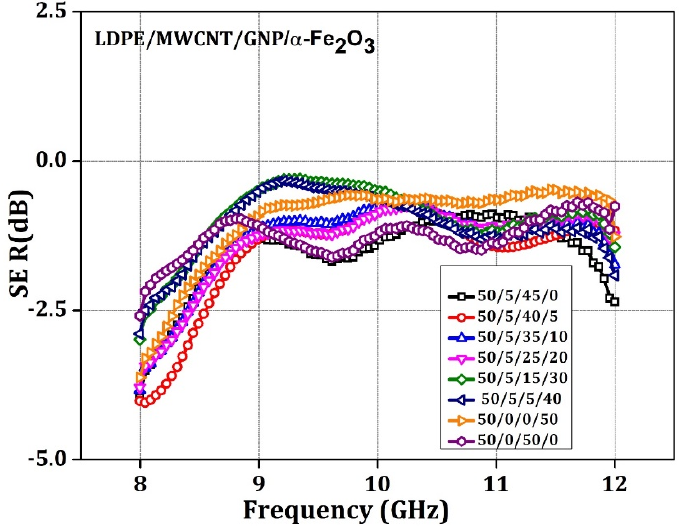
Figure 8. SE R, as a function of frequency, represents the weight % LDPE: MWCNT: GNP: α -Fe 2 O 3 matrix.